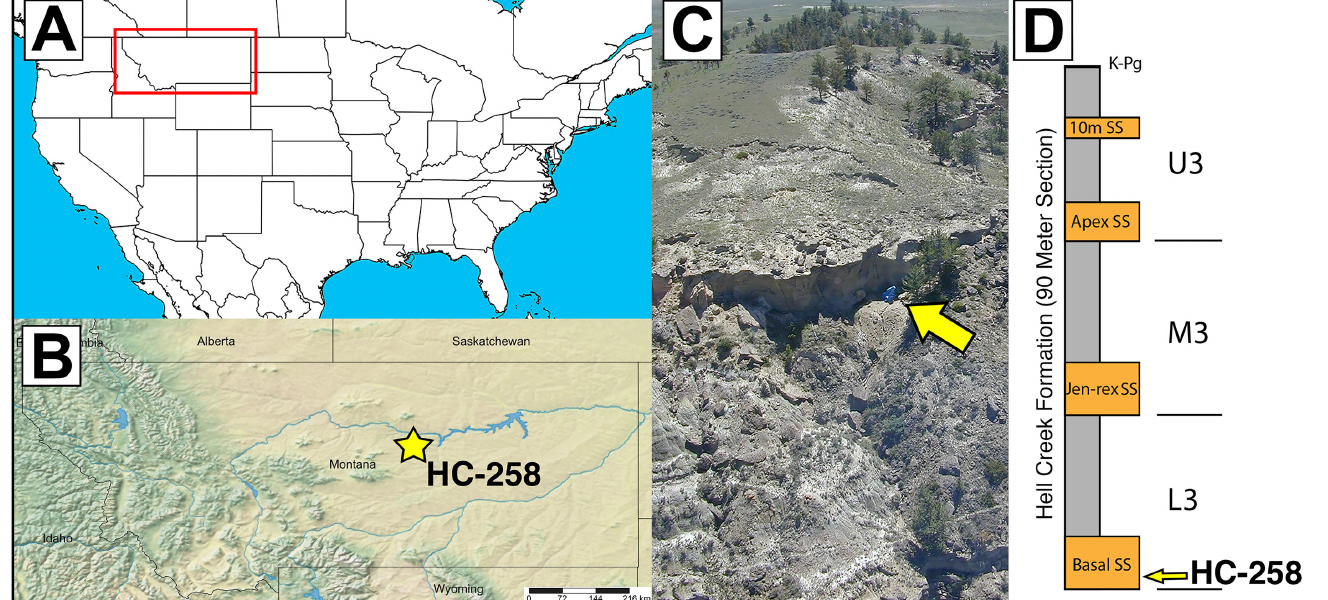
Figure 1. MOR locality HC-258 (‘TORO II’). A) Red box highlights Montana and surrounding area. B) HC-258 plotted on a map of Montana. Detailed locality information on file at MOR. A and B created using Simplmappr (simplmappr.net). C) The HC-258 quarry. Image courtesy MOR. D) Stratigraphic position of HC-258 within the Hell Creek Formation. Generalized stratigraphic section of the formation after Horner et al. (2011) and Scannella and Fowler (2014). The bases of the lower (L3), middle (M3), and upper (U3) units are marked by prominent sandstones (Hartman et al., 2014; Scannella and Fowler 2014; Fowler